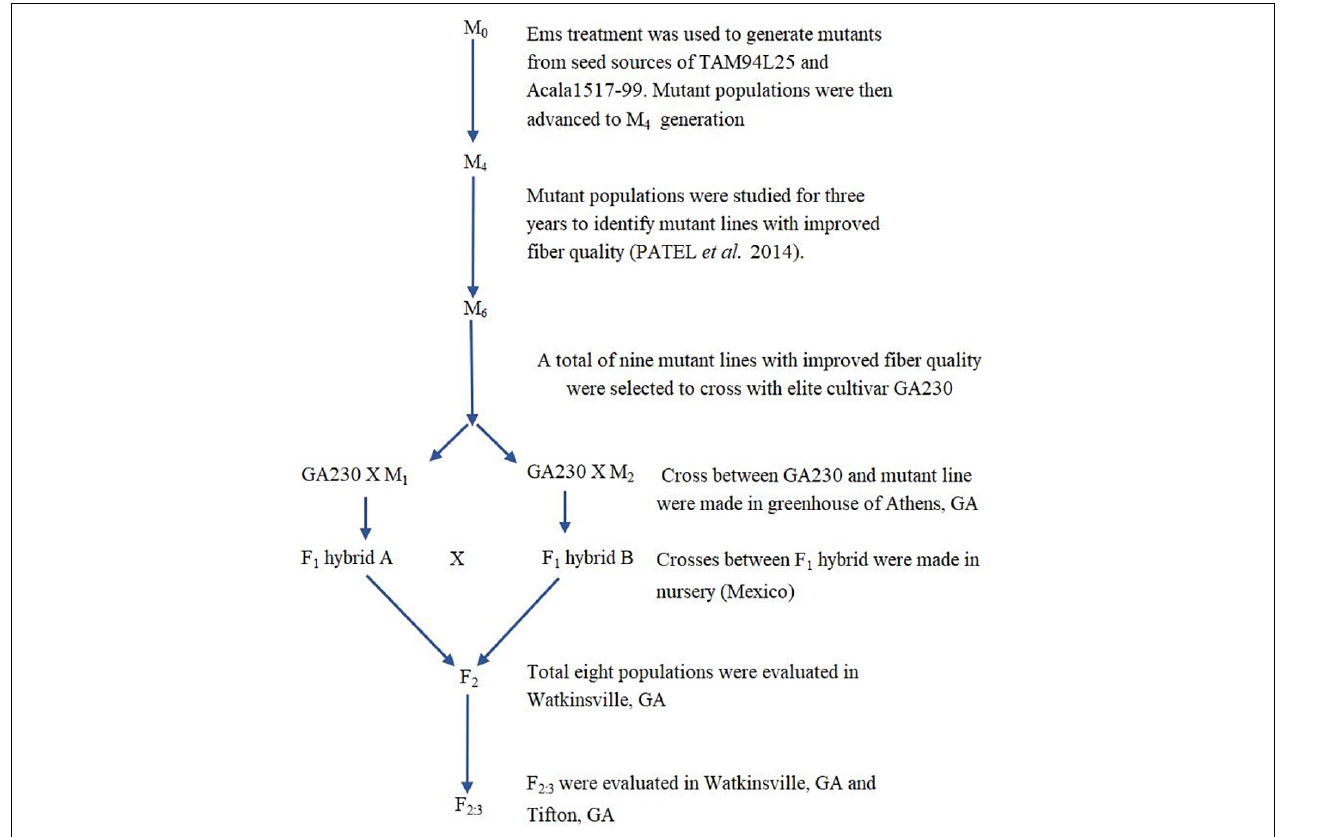
FIGURE 1 | Development of populations for the current research